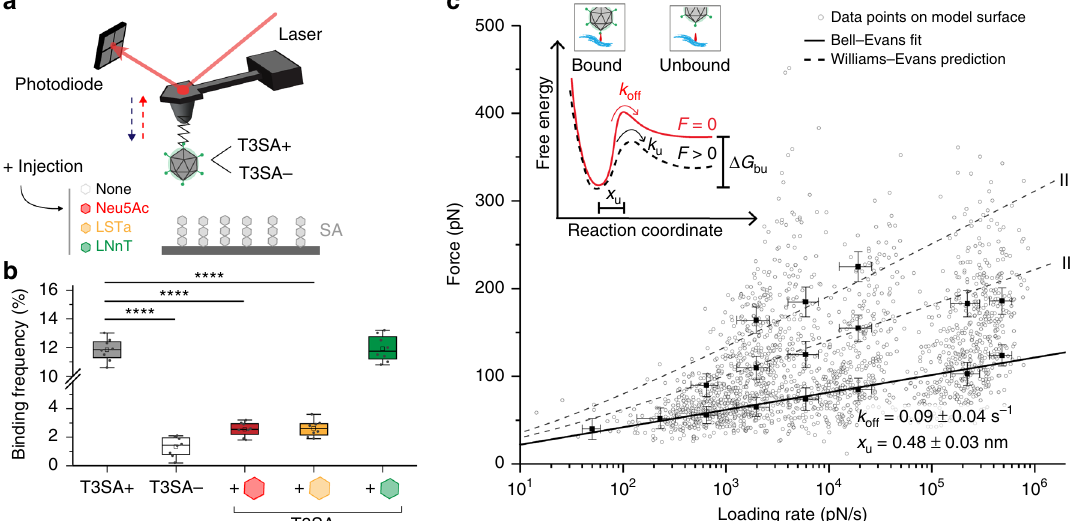
Fig. 2 Probing T3 reovirus binding to sialylated glycans on model surfaces. a Binding of single virions is probed on an SA-coated surface in the presence or absence of α -SA glycan derivatives: N-acetylneuraminic acid (Neu5Ac), sialyl-lacto-N-tetraose a (LSTa), and a derivative without α -SA (lacto-N- neotetraose [LNnT]). b Box plot of speci fi c binding frequencies measured by AFM between virions and α -SA before and after injection of 1 mM glycans. The horizontal line within the box indicates the median, boundaries of the box indicate the 25th and 75th percentile, and the whiskers indicate the highest and lowest values of the results. The square in the box indicates the mean. c Dynamic force spectroscopy (DFS) plot showing the distribution of rupture forces measured between T3SA + and the SA-coated surface (gray dots) with average rupture forces determined for eight distinct loading rate (LR) ranges. Data corresponding to single interactions are fi tted with the Bell-Evans (BE) model describing a ligand-receptor bond as a simple two-state model (I, black curve). Dashed lines represent the predicted binding forces for two (II) and three (III) simultaneous uncorrelated interactions (Williams-Evans model [WEM]). Inset: BE model describing a ligand-receptor bond as a simple two-state model. The bound state is separated from the unbound state by an energy barrier located at distance x u . k u and k off represent the transition rate and transition at thermal equilibrium, respectively. Error bars indicate s.d. of the mean value. For all experiments, data are representative of n = 5 independent experiments. **** P < 0.0001; determined by two-sample t -test in